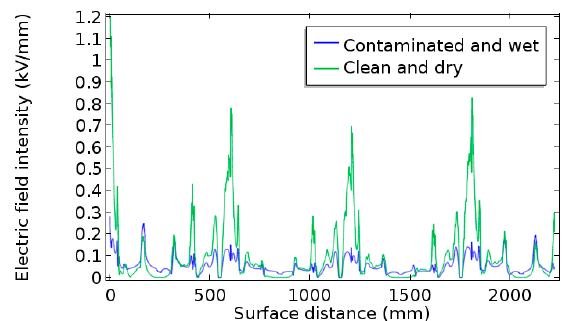
Figure 11. Electric field distribution along insulator string under contaminated and wet condition.